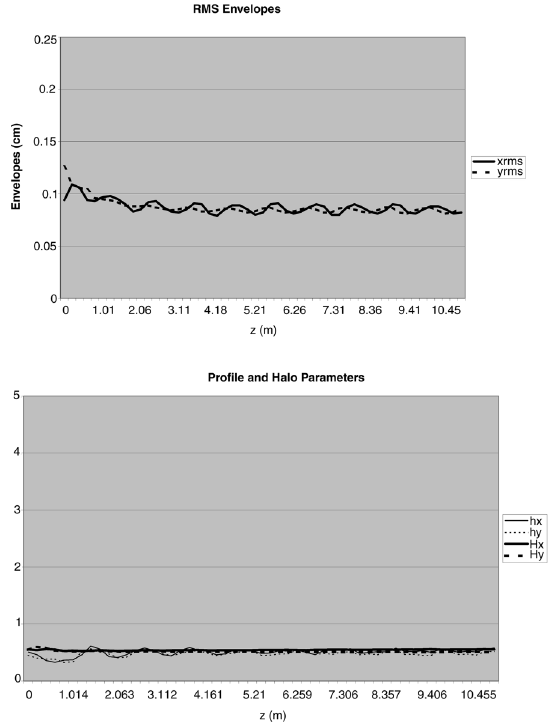
FIG. 1. rms envelopes and halo parameters for the matched